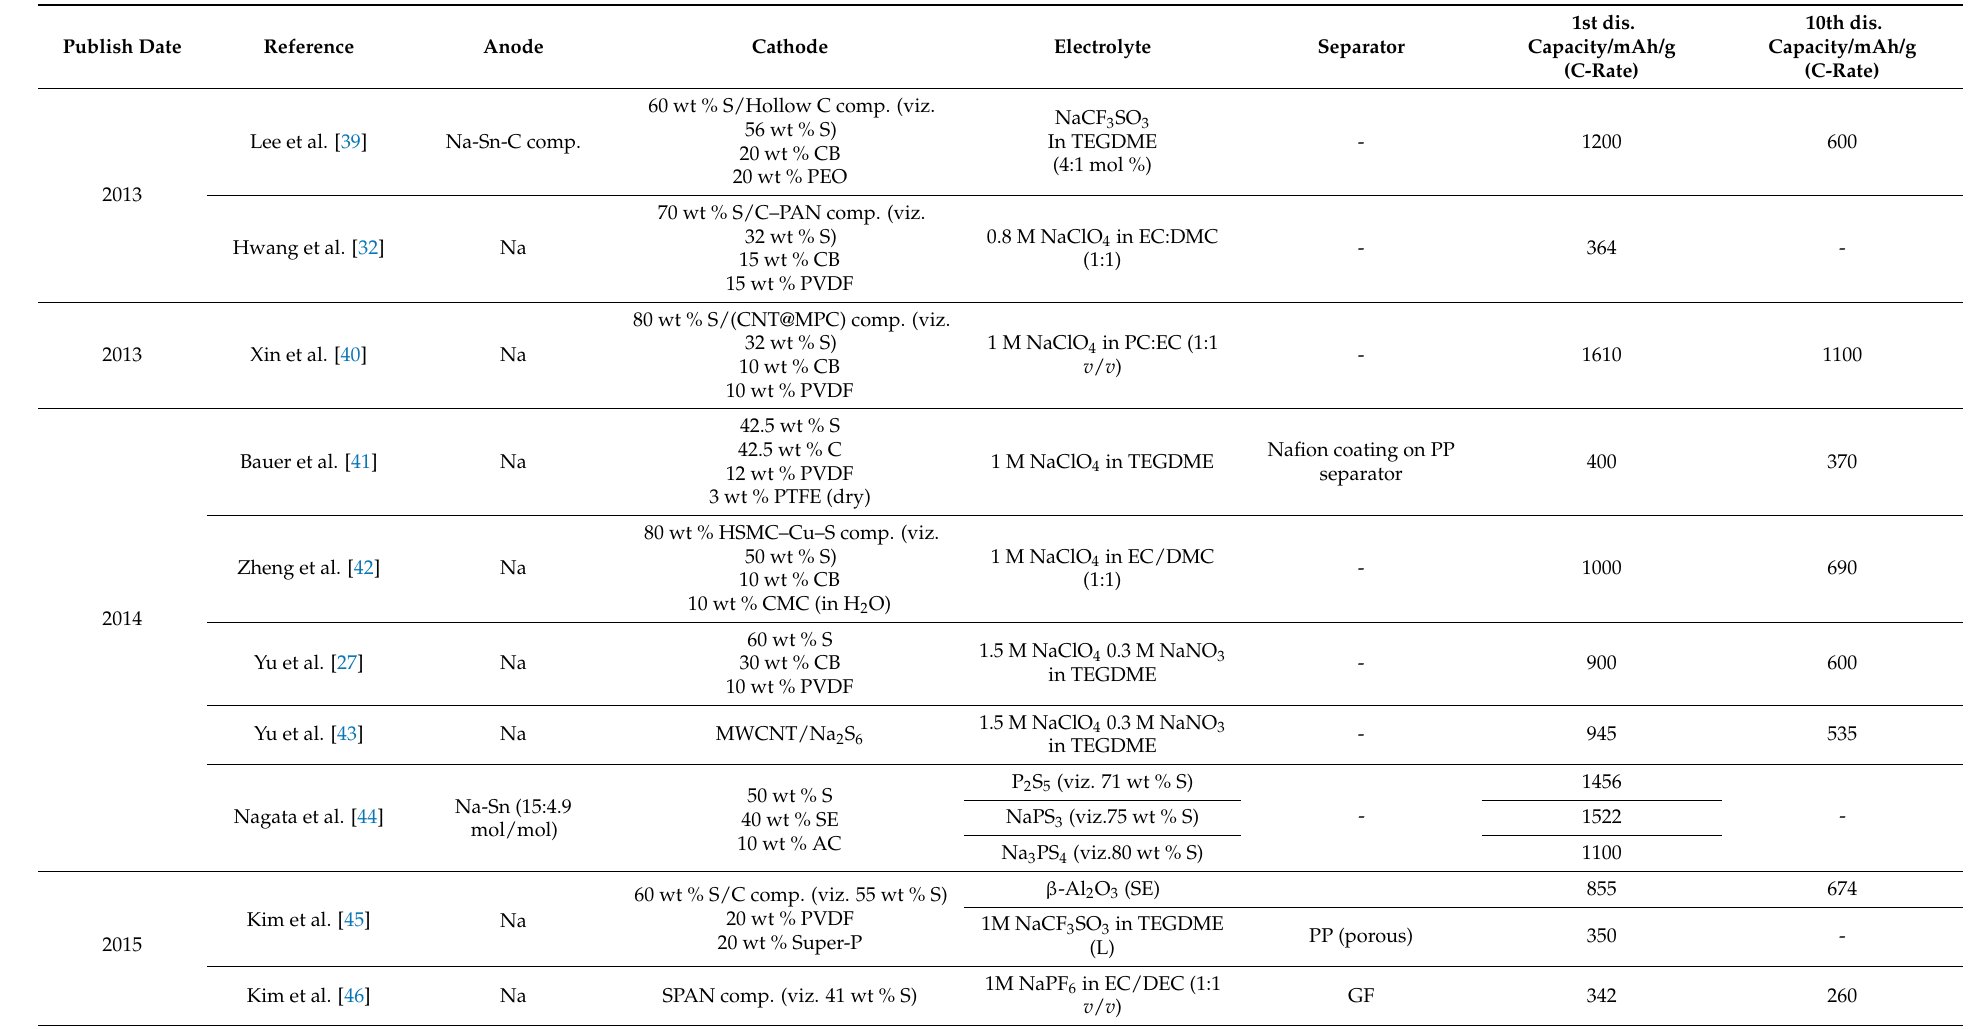
Table 1. The main research progress of room temperature sodium–sulfur batteries in the past six